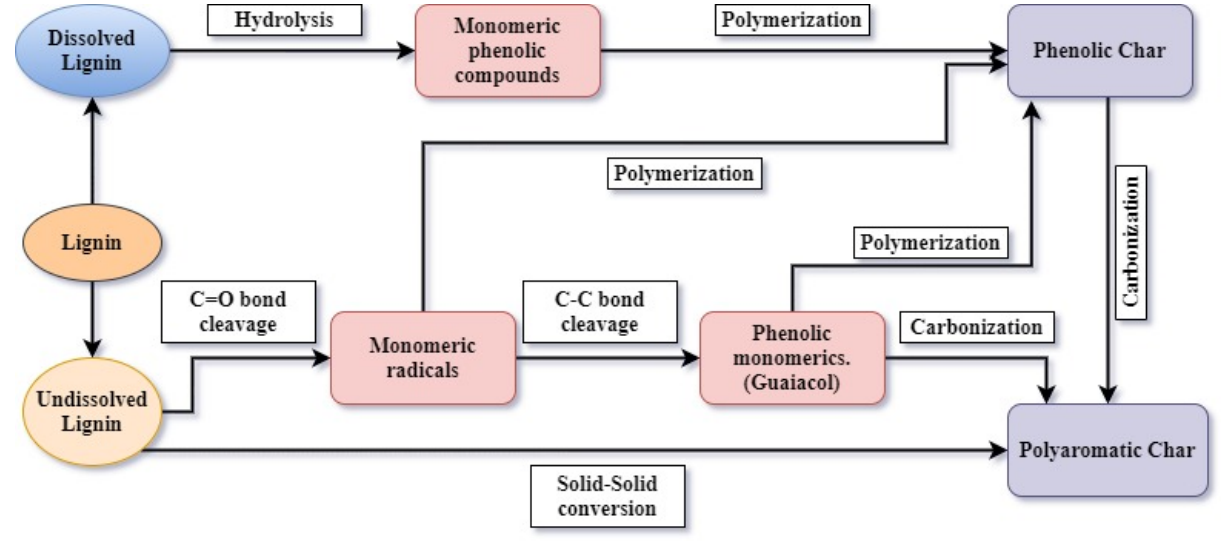
Figure 13. Reaction mechanism for char formation from lignin